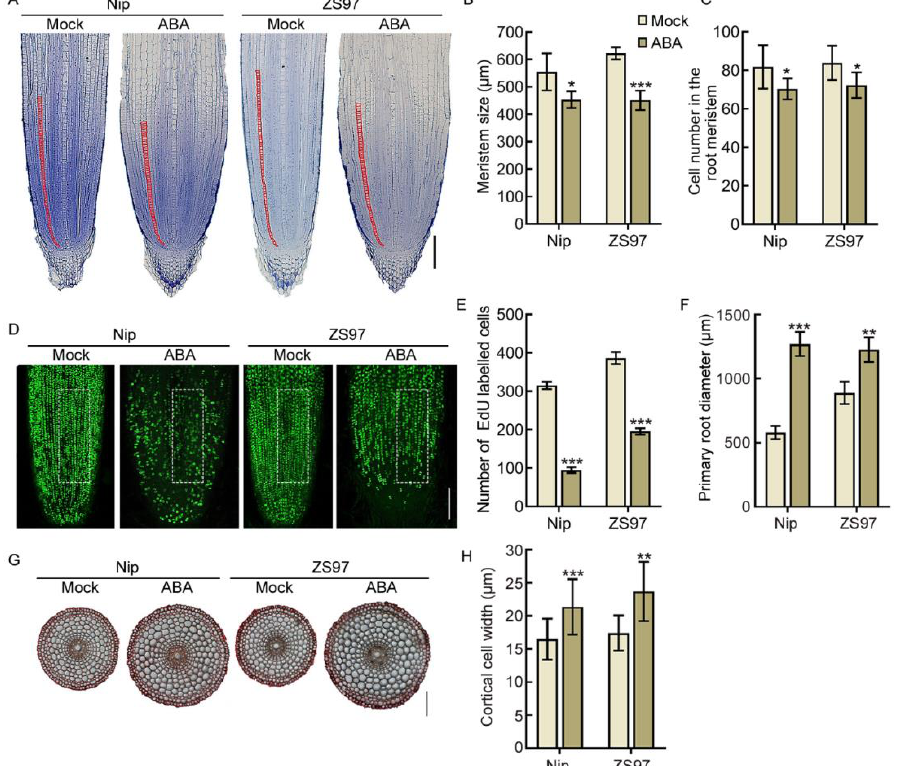
Figure 4. ABA inhibits cell proliferation and promotes cortical cell expansion in the root meristem. ( A ) Longitudinal sections of primary root tips (lower) of 4-day-old Nip and ZS97 seedlings treated with 0 µ M (Mock) and 1 µ M ABA. Red lines delimit the meristem size (i.e., the distance between the quiescent center and the transition zone). Bar = 100 µ m. ( B , C ) Length of root meristematic zone ( B ) and cortical cell number in the root meristem zone ( C ) of the corresponding seedlings indicated in ( A ). ( D ) EdU-labelled cells in the root meristem of 4-day-old Nip and ZS97 seedlings treated with 0 µ M (Mock) and 1 µ M ABA. Bar = 100 µ m. ( E ) Number of EdU-labelled cells in ( D ). Quantification was performed in the unit area (white box) of the root tip. ( F ) Primary root diameter of the corresponding seedlings indicated in ( A ). ( G ) Cross-sections of primary root tips (lower) of 4-day-old Nip and ZS97 seedlings with or without 1 µ M ABA treatment. Bar = 100 µ m. ( H ) Diameter of cortical cells in ( G ). In ( B , C , E , F , H ), data are means ± SD ( n ≥ 10 independent seedlings). The asterisks indicate significant differences compared to mock (* p < 0.05, ** p < 0.01, *** p < 0.001, Student’s t